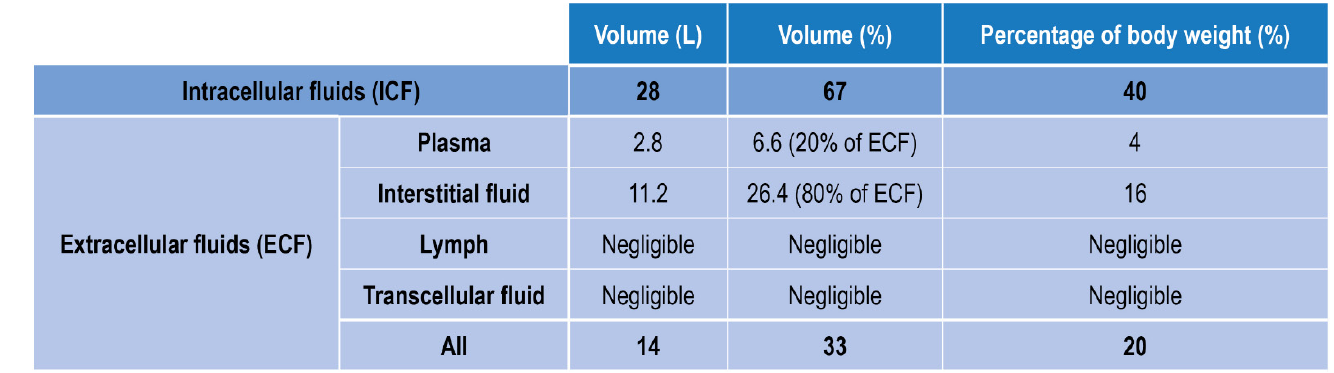
Figure 1. Body fluids classification and relative amount in volume and weight.